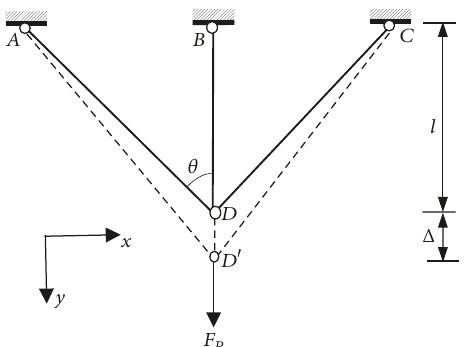
Figure 11: Three-bar plane truss.